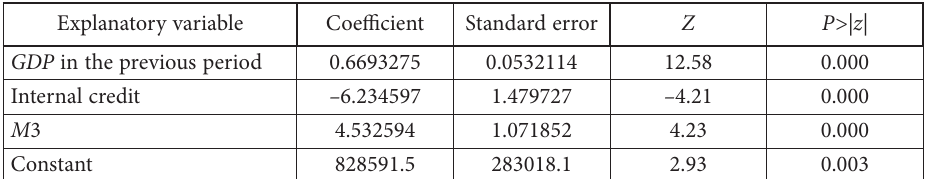
Table 8. Dynamic panel model with Arrelano-Bover/Blundell-Bond estimator (source: authors’